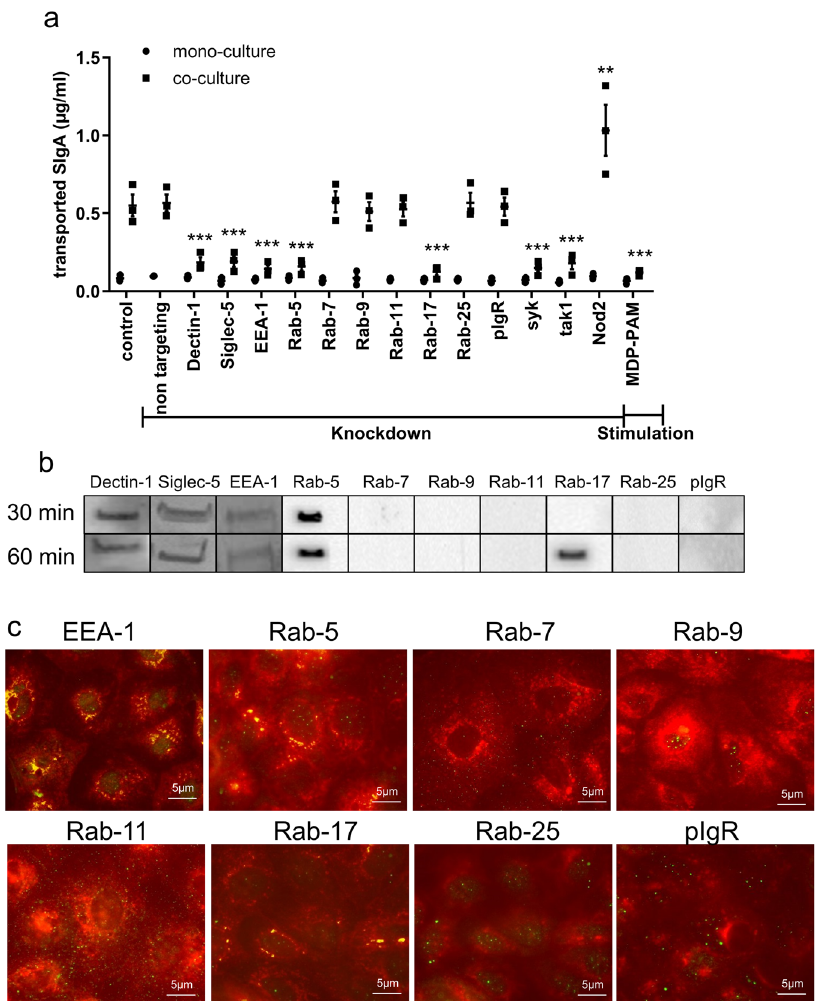
Fig. 4 IgA reverse transcytosis after protein inhibition or stimulation. After siRNA knockdown or muramyl dipeptide — Pam3Cys (MDP-PAM) stimulation, IgA2 conjugated with luciferase a transport were quanti fi ed in the inverted in vitro model of FAE. Vertical bars show the mean value ± SEM. n = 3 independent experiments. One-way ANOVA followed by Bonferroni post hoc test was used ( p values: ** p < 0.01; *** p < 0.005). b Immunoprecipitation made 30 or 60 min after IgA incubation. This experiment was repeated twice with similar results. c Immuno fl uorescence staining after IgA incubation (60 min), with FITC anti-human IgA and anti-Rabs mAbs or anti-EEA-1 mAbs followed by corresponding PE secondary Abs. Colocalization between IgA and endosomal proteins resulted in yellow dots present in EEA-1, Rab-5, and Rab-17 images. This experiment was repeated twice with similar results. Source data are provided as a Source Data fi